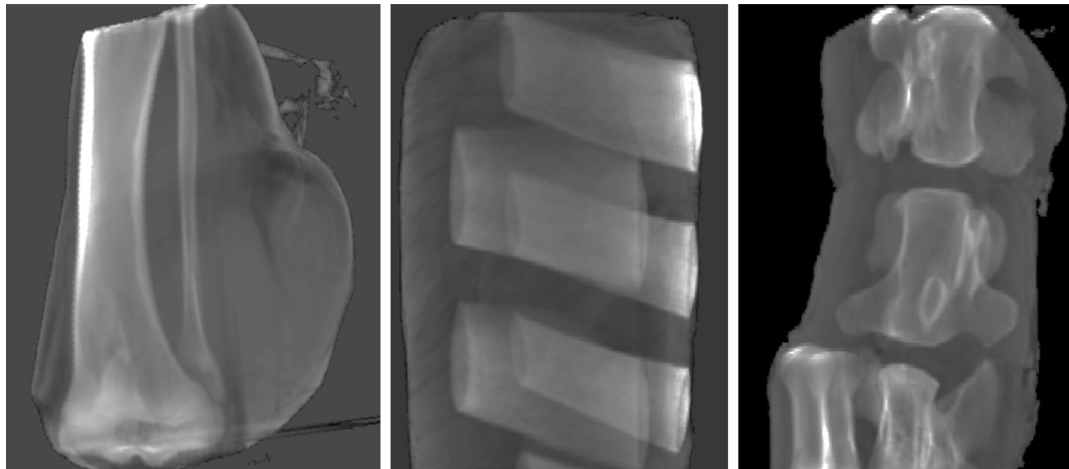
Figure 6. Renderings of porcine and bovine tissue samples applying summed voxel projection. From left to right: porcine knuckle (leg), bovine rib cut, and bovine vertebrae in oxtail